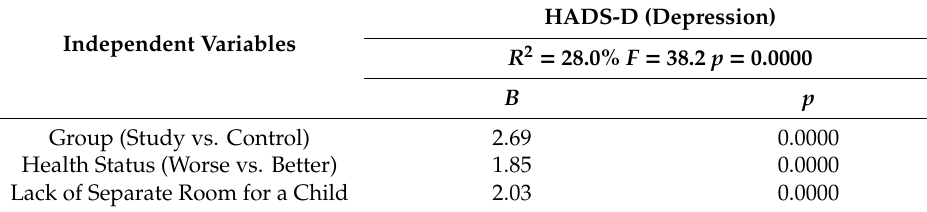
Table 5. Regression model for predicting HADS-D.